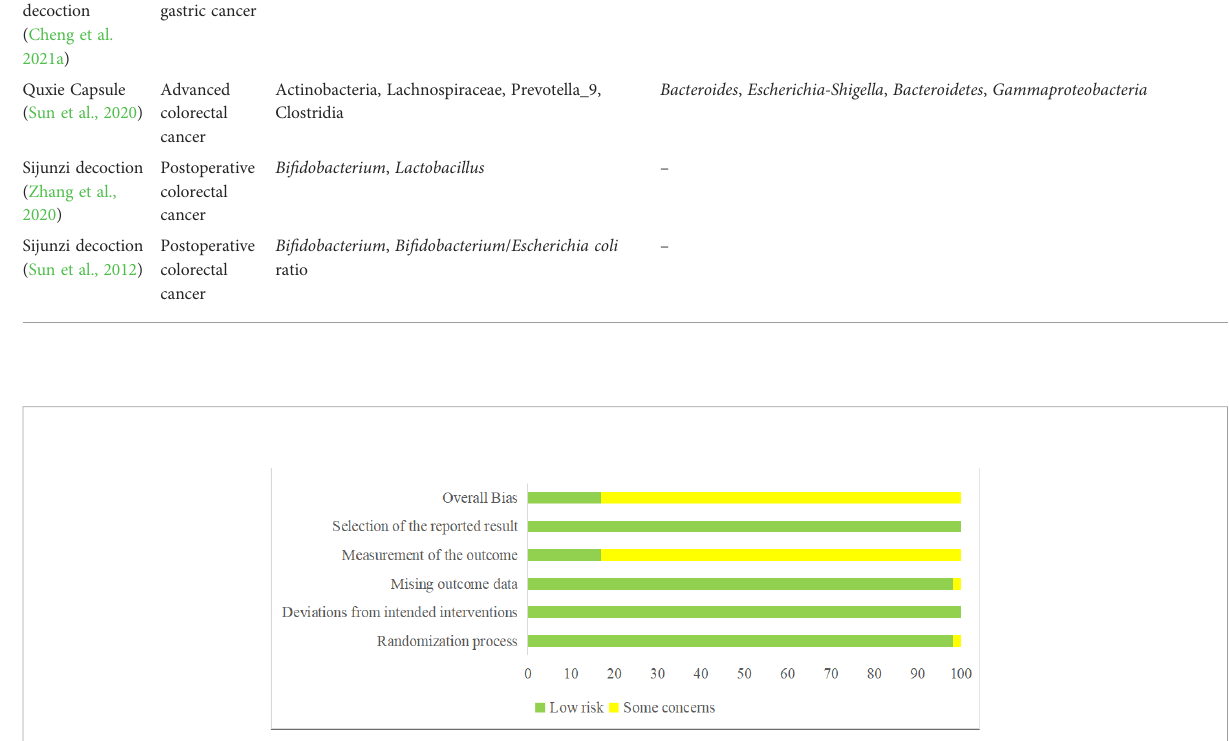
FIGURE 2 Risk of bias of included